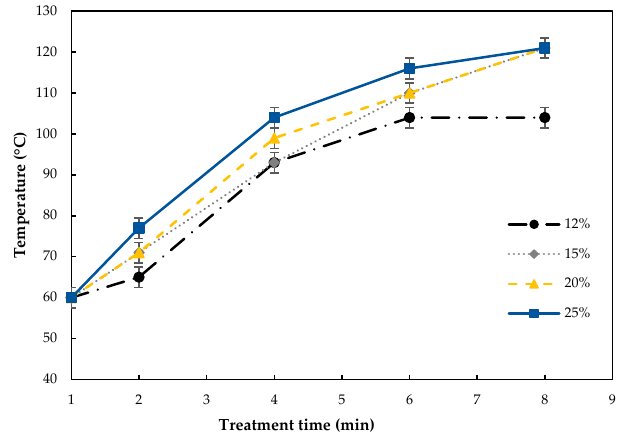
Figure 1. Evolution of the temperature of tef flour during the treatment at 12%, 15%, 20%, and 25% moisture content. Table 1. Microwave treatment conditions and identification of samples.